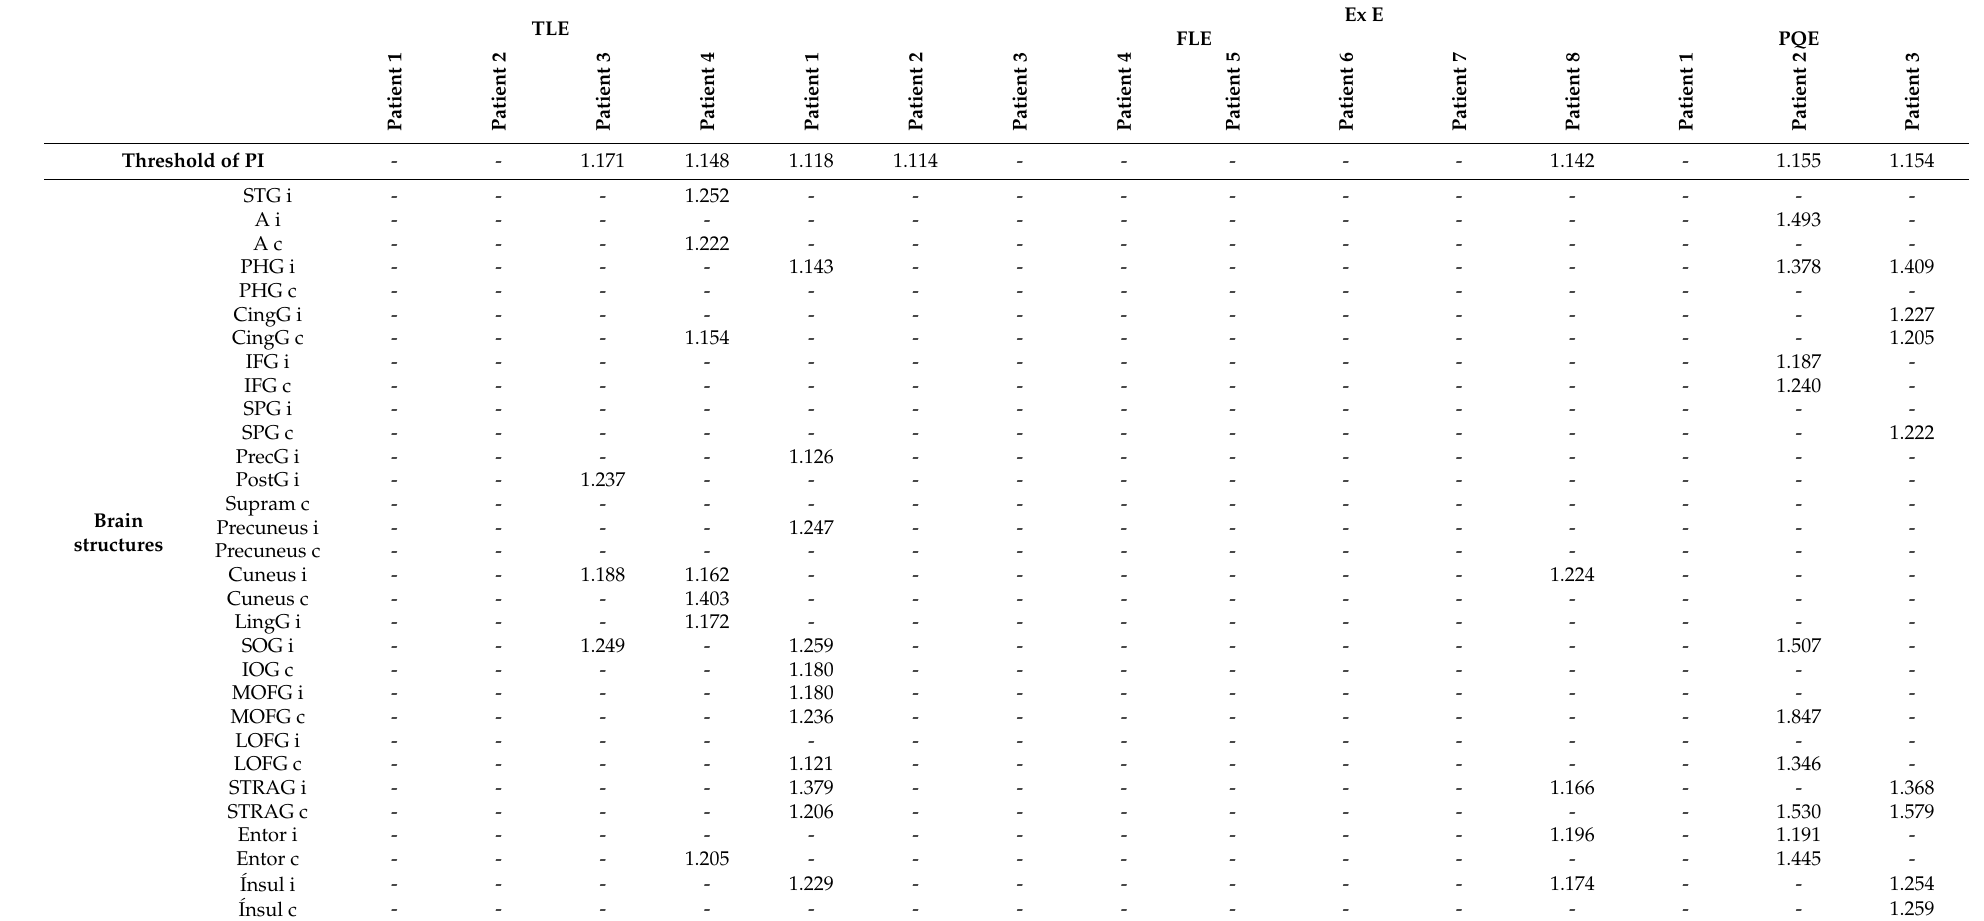
Table 4. Brain structures with values above the established threshold of the Perfusion Index (ictal state).